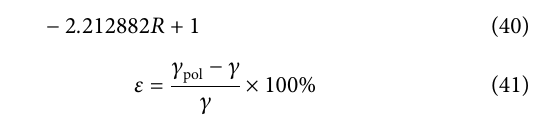
Case 1: Constant BHP Condition Case 1 is characterized by the constant BHP of 44.4363 MPa and the production pro fi le within 2000 days is shown in Figure 6A ).